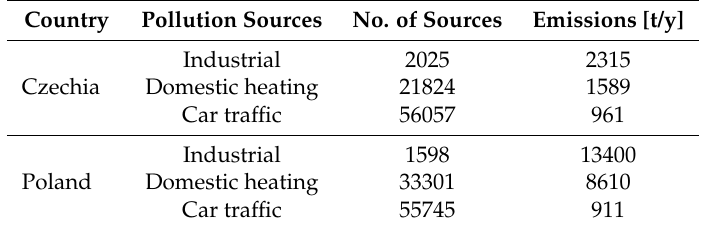
Table 1. The PM 10 pollution sources in the study area, (Air Silesia, 2013).